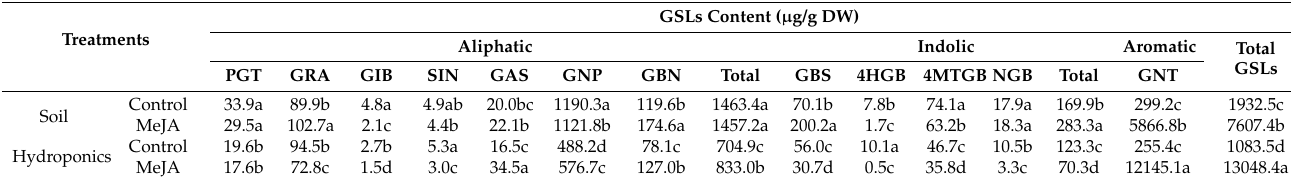
Figure 3. Glucosinolate contents of pak choi grown in soil or hydroponics with or without the treatment of MeJA. Different letters on the bars indicate a significant difference ( p < 0.05) between the treatments. The vertical bars represent the standard error of the mean ( n = 3). Table 1. Individual glucosinolate contents of pak choi ( Brassica rapa L. ssp. Chinensis ) grown in soil or hydroponics with or without the treatment of methyl jasmonate (MeJA).